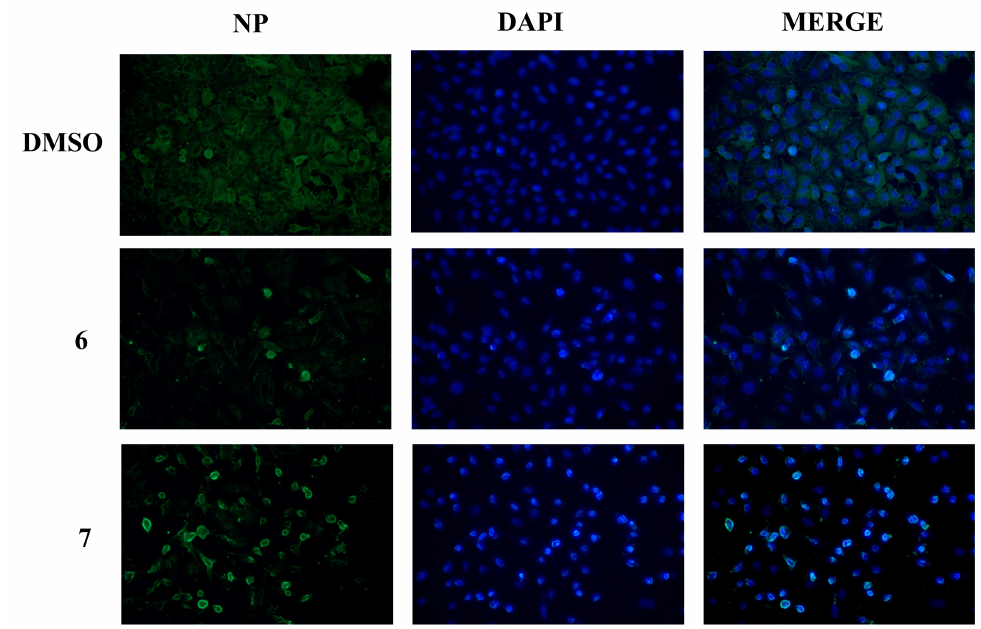
Figure 6. Compounds 6 and 7 retain viral NP in the nucleus. Immunofluorescence analysis of viral nucleoprotein (NP, green) in A549 cells infected for 24 h with influenza A/PR/8/H1N1 virus and treated with compounds 6 , 7 , or DMSO solvent. Nuclei were stained with DAPI (blue). Images represent one experiment of two